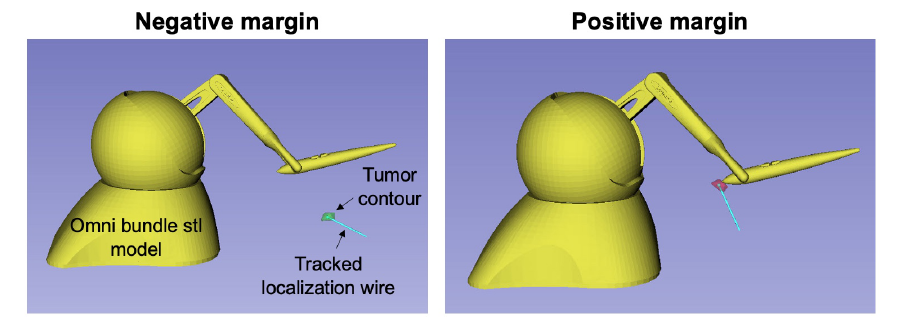
Figure 8. Application of cooperative robotics in previously recorded navigated lumpectomy surgery. ( Left ) Negative margin—when the robot/cooperatively guided tool is outside of the tumor. ( Right ) Positive margin—when the robot/cooperatively guided tool is inside of the tumor. Note that breast tumors are generally small